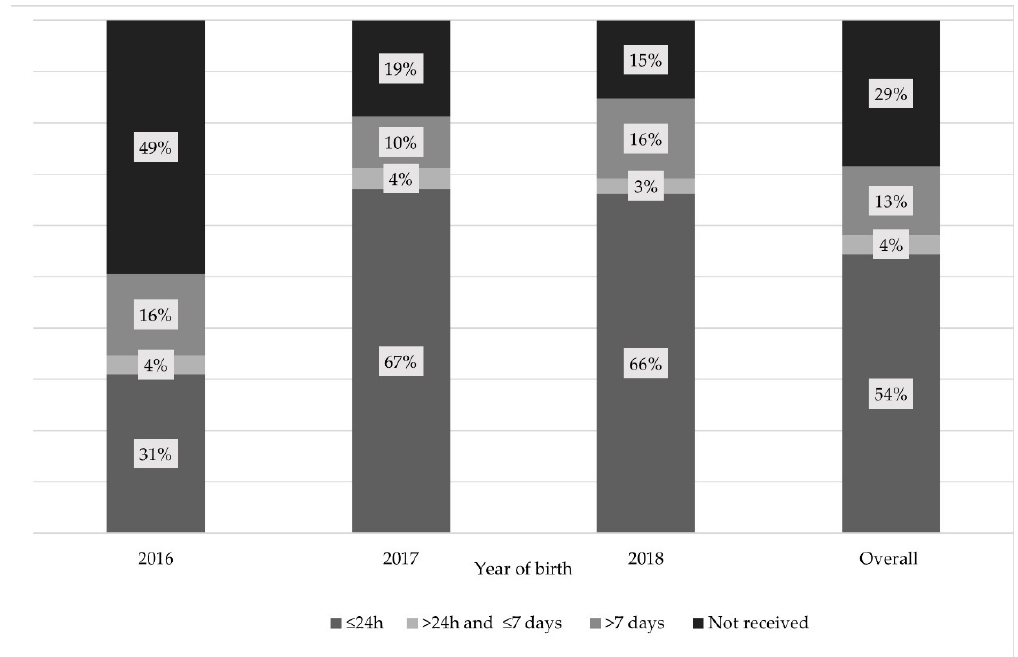
Figure 1. Coverage and administration timeframes of hepatitis B virus (HBV) vaccine birth dose (BD) in children born after its introduction in Senegal’s national Expanded Programme on Immunisation in 2016, per year of birth (percentage of children) (ANRS 12356 AmBASS survey, n = 241 children living in the rural area of Niakhar with available vaccination data, using weighted and calibrated data).